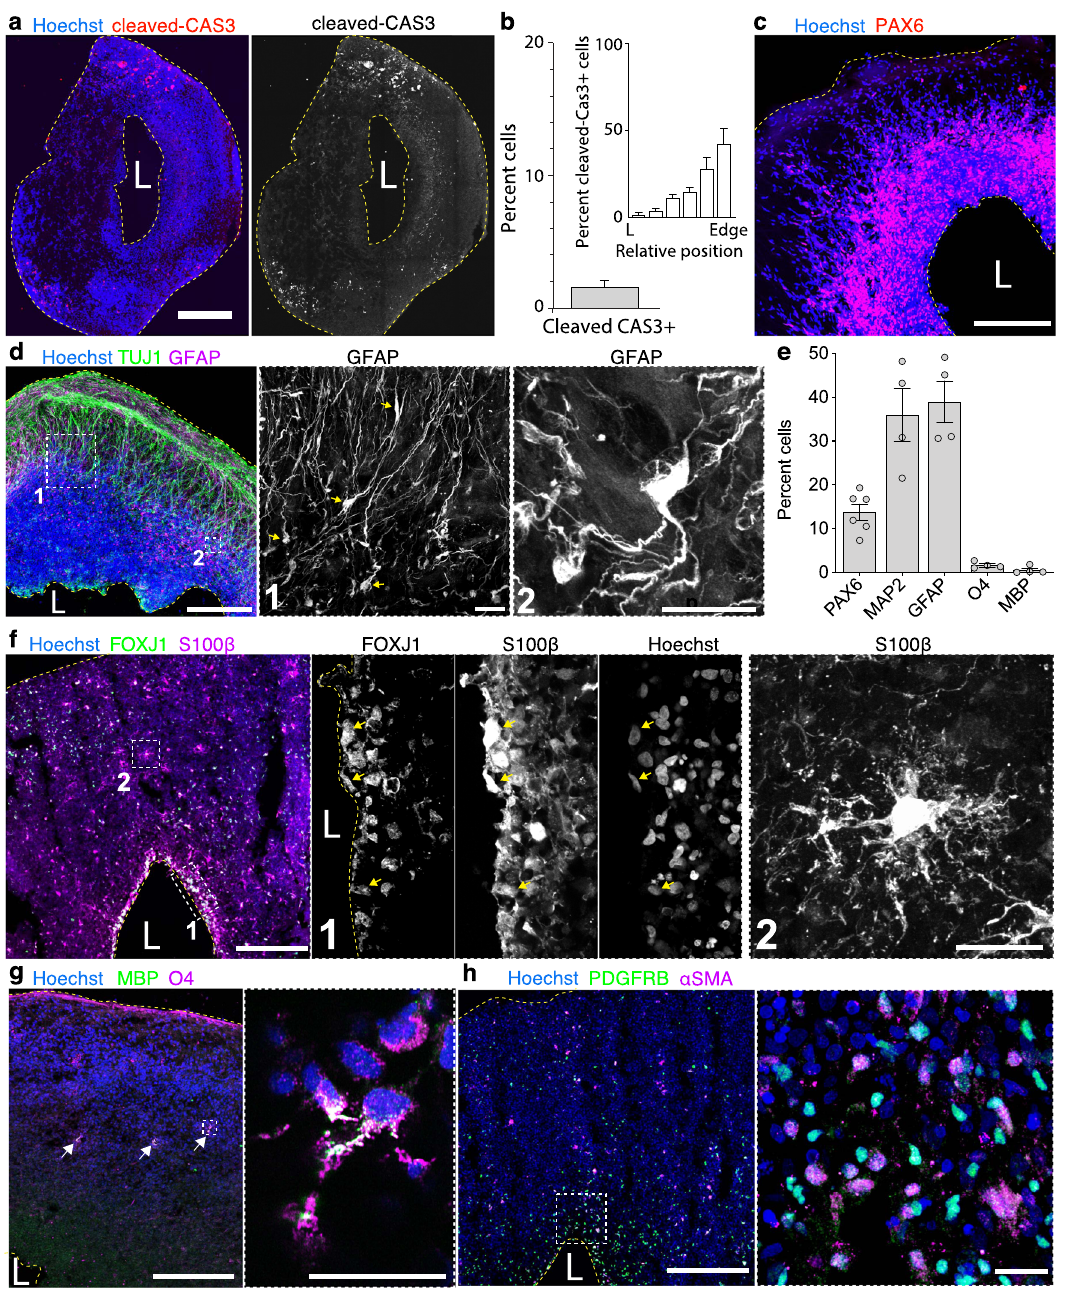
Fig. 6 | Diversity of neural cells, including outer radial glia, astrocytes, and ependymal- and periendothelial-like cells are generated in 5-month-old SNR- derived organoids. a Organoid section immunostained for cleaved caspase-3. b Percentage and distribution of cleaved caspase 3-expressing cells in organoid sections ( n =4 sections from two organoids produced in two batches from 2242-5 and H9 lines). c , d , f – h Organoid sections immunostained for PAX6 ( c ), TUJ1 and